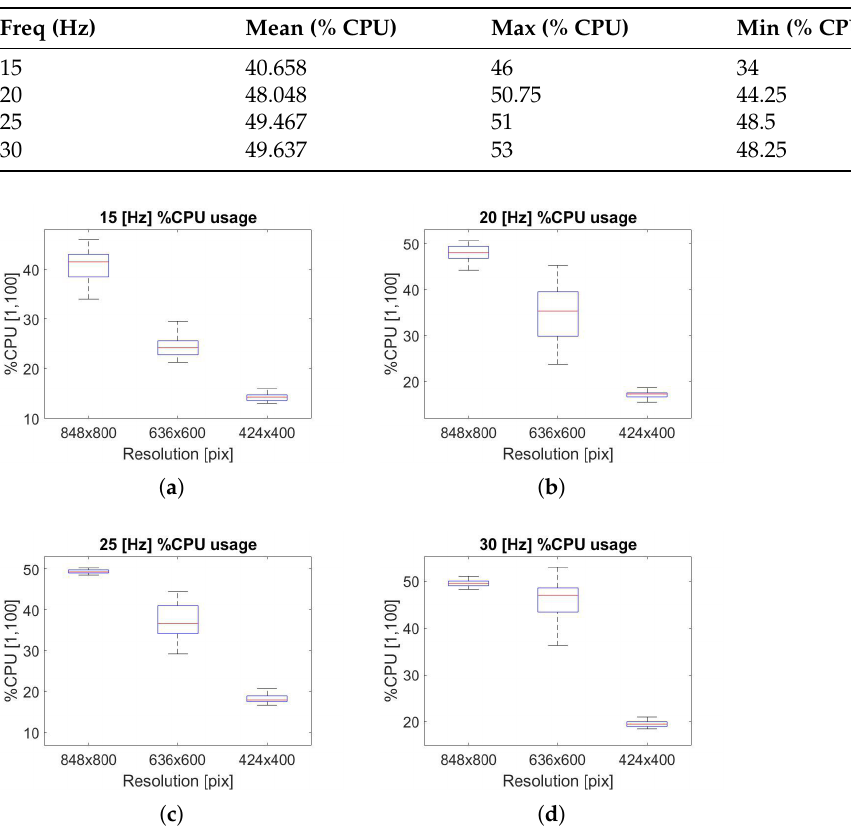
Figure 13. ( a ) CPU usage, 15 Hz; ( b ) CPU usage, 20 Hz; ( c ) CPU usage, 25 Hz; ( d ) CPU usage, 30 Hz. Jetson Nano board computational cost analysis along the trajectory performed by varying the resolution.